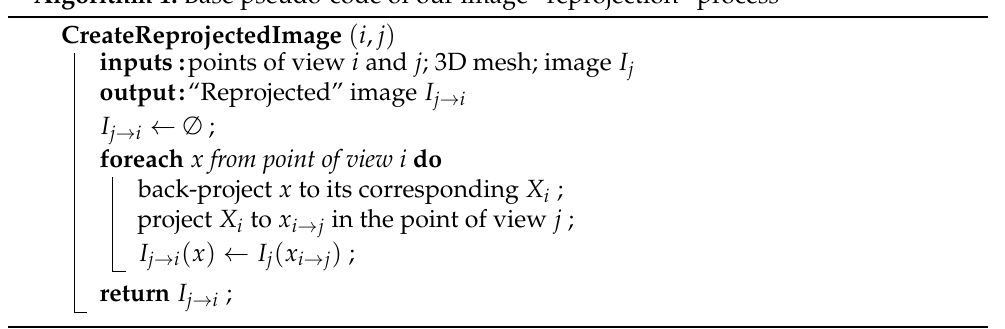
Algorithm 1: Base pseudo-code of our image “reprojection” process